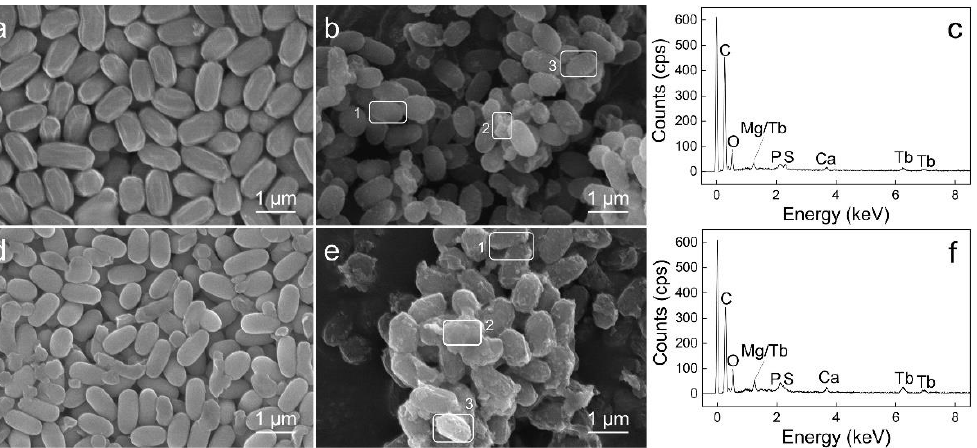
Figure 5. SEM micrographs of ( a ) PS533 spores, ( b ) PS4150 spores, ( d ) PS533 spores − Tb, and ( e ) PS4150 spores − Tb. EDS spectrum of ( c ) PS533 spores − Tb and ( f ) PS4150 spores − Tb. Counts results are calculated from the average of the energy intensities of the three regions of the spore after ad- sorption.